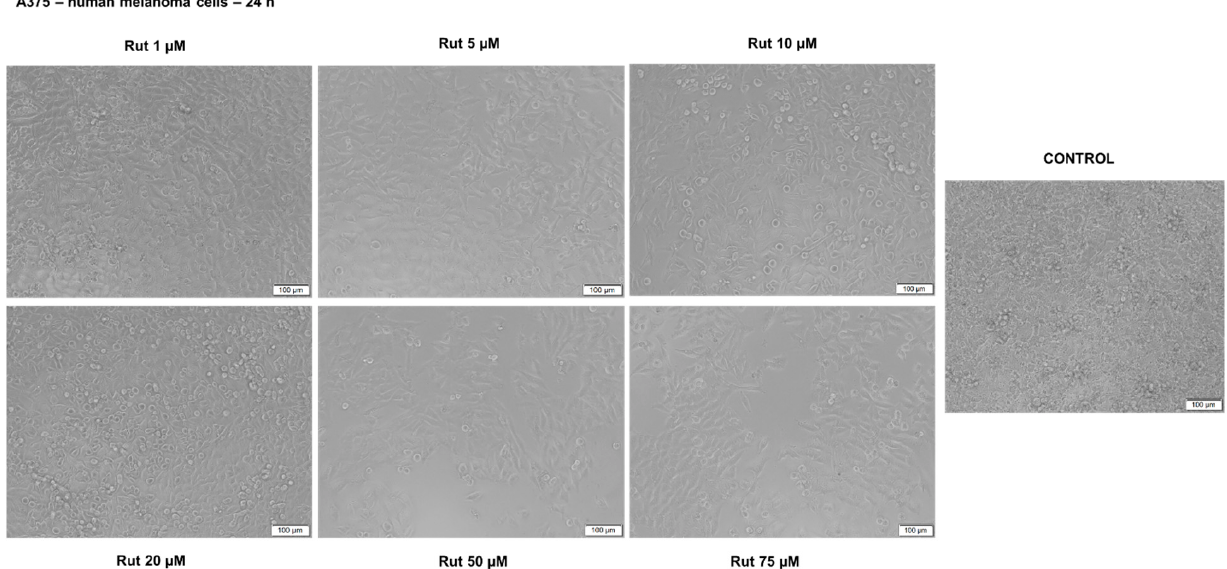
Figure 12. Morphological aspect of A375 cells after treatment with Rut (1, 5, 10, 20, 50 and 75 µM) for 24 h. The pictures were taken 24 h posttreatment. The scale bars represent 100 µm.